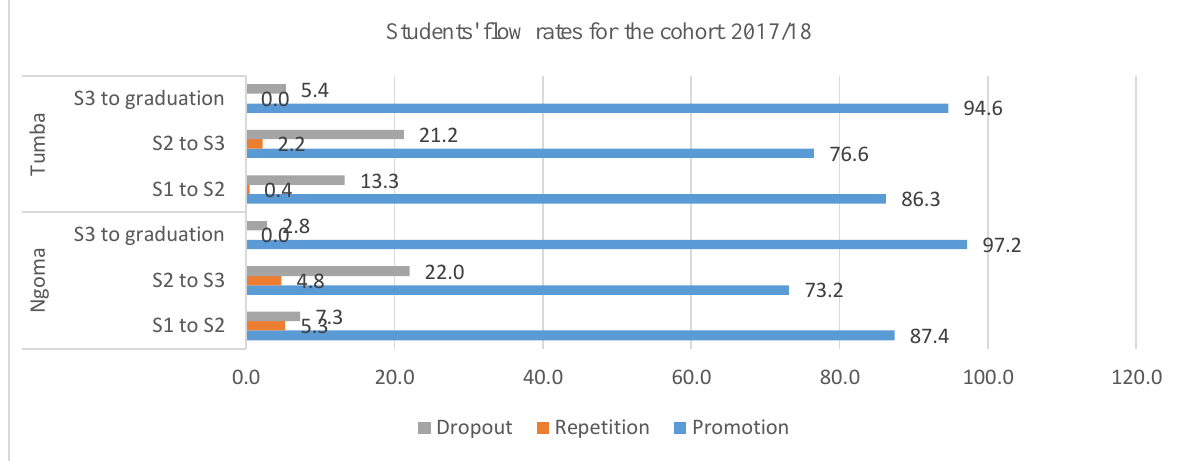
Figure 2: Students’ flow rates in Ngoma and Tumba Schools, Cohort